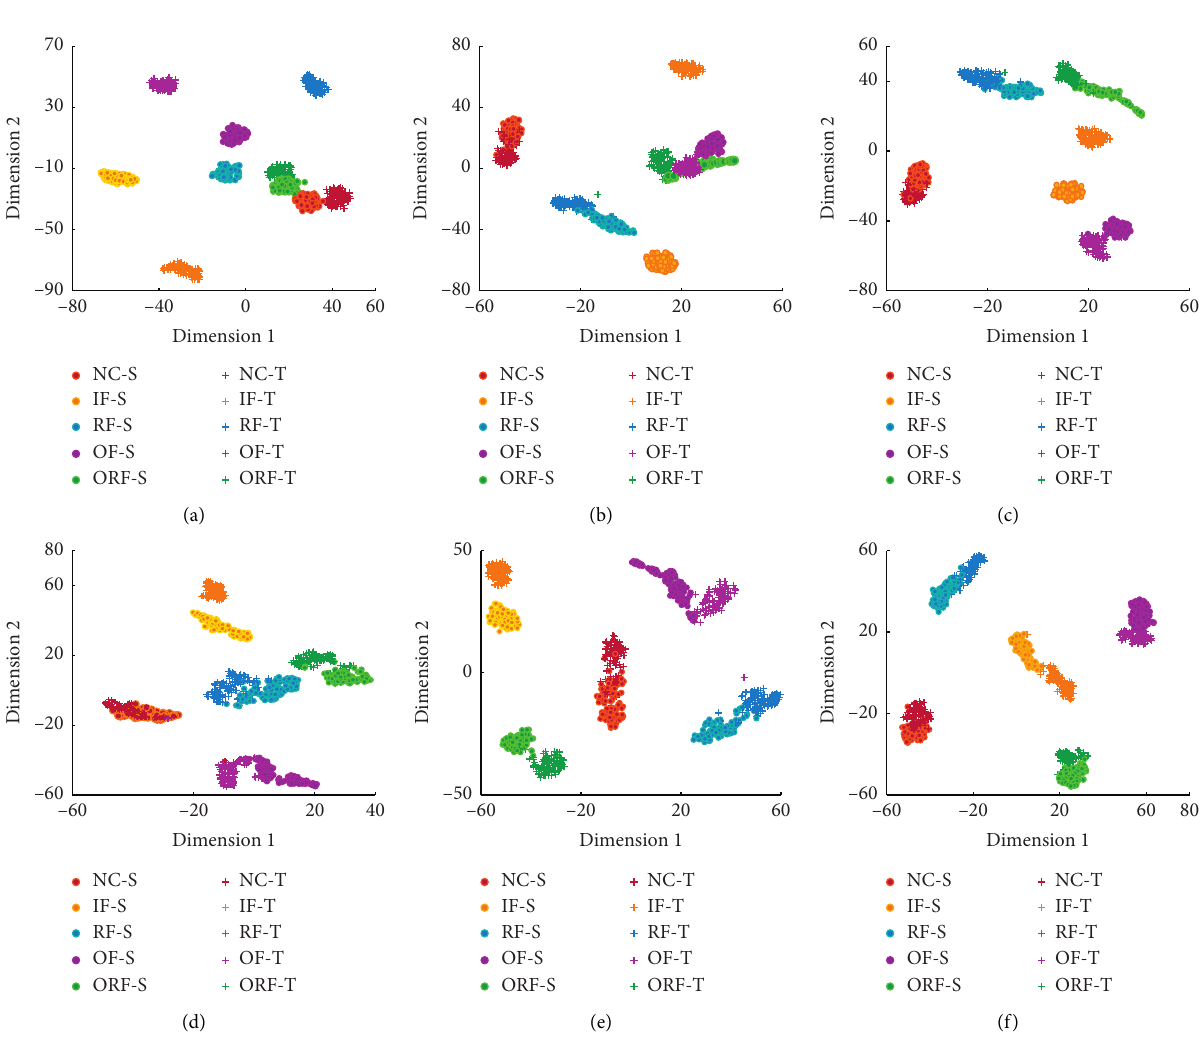
Figure 8: Scatter diagram in case D ⟶ E: (a) SAE, (b) TCA, (c) DANN, (d) MK-MMD, (e) SFDA, and (f)